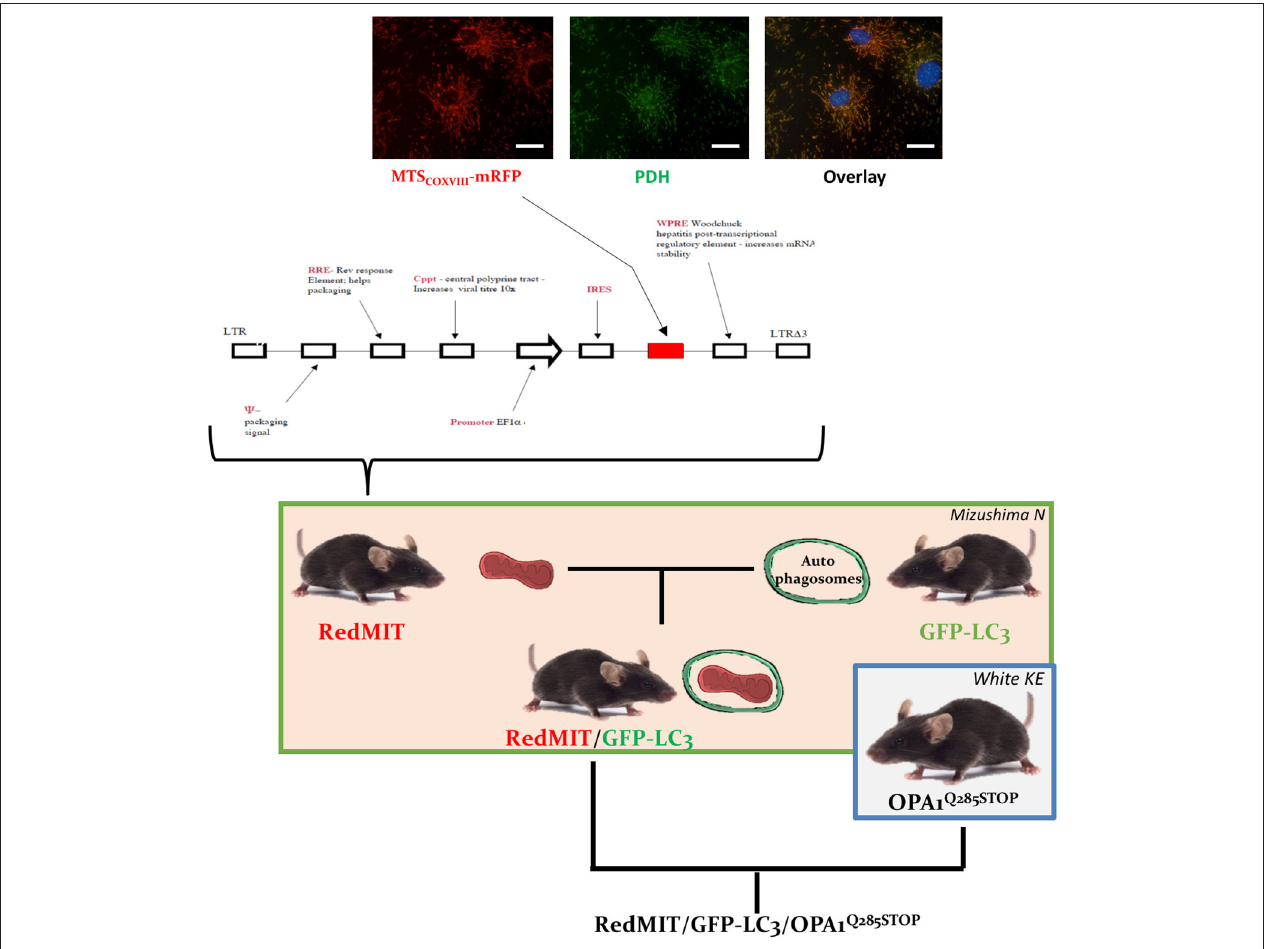
FIGURE 1 | The RedMIT-GFP-LC3-OPA1 Q285STOP mouse. The RedMIT mouse has been genetically engineered by random insertion of the illustrated construct. The mRFP fluorescent protein is fused to the mitochondrial targeting sequence of COX VIII and its expression perfectly colocalizes with PDH (panel, scale bar = 20 µ m). Expression is under the control of the EF1 α promoter. Homozygous females were then crossed to GFP-LC3 males (Mizushima et al., 2004) to obtain our RedMIT-GFP-LC3 mouse model. Once both fluorescent markers were homozygous, RedMIT-GFP-LC3 mice were crossed to the OPA1 Q285STOP mice (White et al., 2009